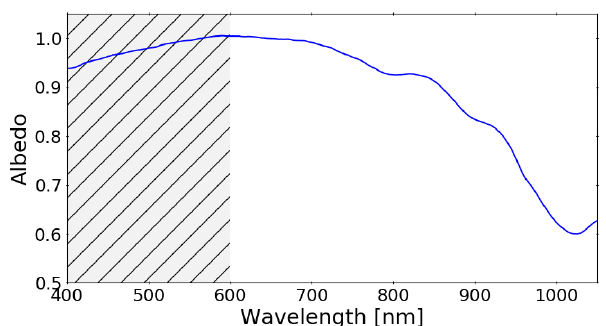
Figure 3. Measured spectral albedo from 400 to 1050nm. The grey area with vertical lines (from 400 to 600nm) is the wavelength range the most affected by the concentration of snow LAPs (im- purities). The spectrum is the one acquired over the A smooth site (Table